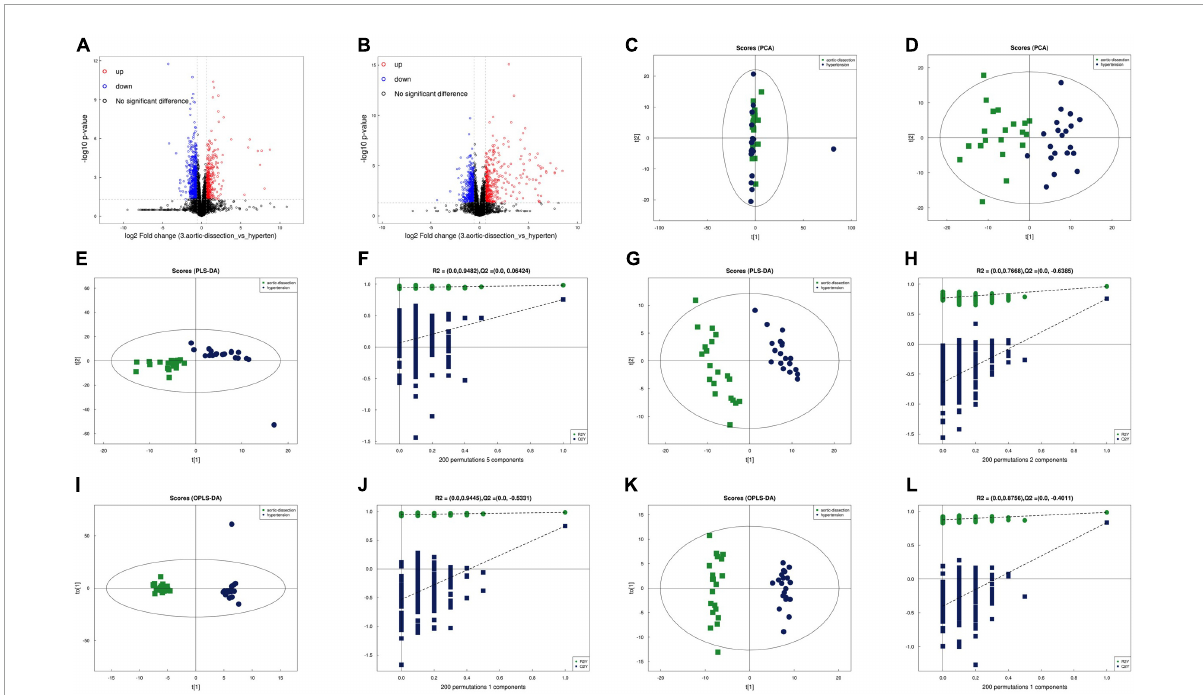
FIGURE1 Separation and classification of metabolic profiles in plasma from the AAD and hypertension groups. Volcano plot of positive (A) and negative (B) ion mode results. PCA score plots of the AAD and hypertension groups in the positive (C) and negative (D) ion modes. PLS-DA score plots of AAD and hypertension groups in the positive (E) and negative (F) mode and the cumulative fitness (R 2 value) and prediction power (Q 2 value) of the PLS-DA analysis in the positive (G) and negative (H) ion mode. OPLS-DA score plots of AAD and hypertension groups in the positive (I) and negative (J) ion mode and the cumulative fitness (R 2 value) and prediction power (Q 2 value) of the OPLS-DA analysis in the positive (K) and negative ion modes (L) . The t [1] and t [2] values in the figures represent the scores of each sample in principal components 1 and 2, respectively. Each dot on the plot represents a sample in the corresponding group. PCA: principal component analysis; PLS-DA: orthogonal partial least square discriminant analysis; PLS-DA: a partial least square discriminant